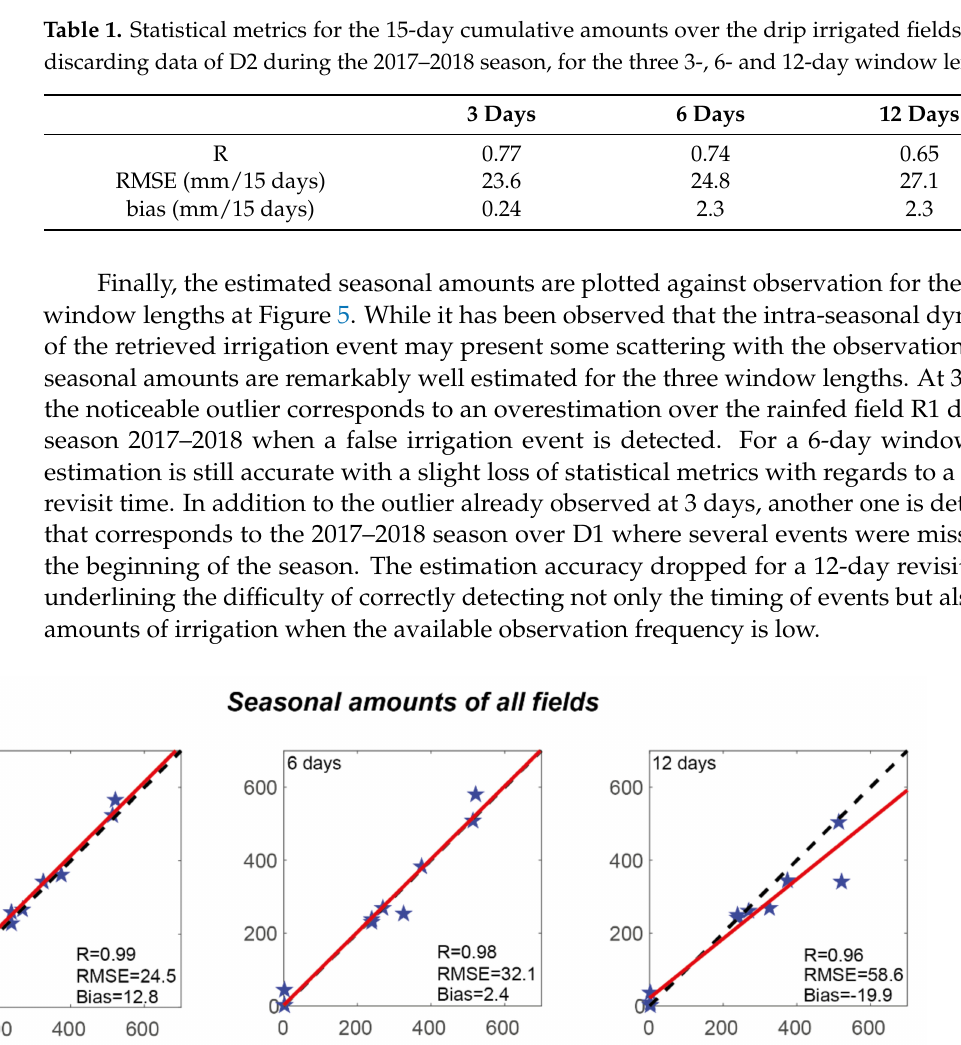
Table 1. Statistical metrics for the 15-day cumulative amounts over the drip irrigated fields when